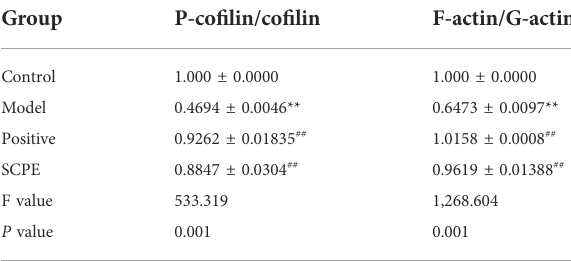
TABLE 6 Effect of SCPE on CYP19 mRNA expression in the hippocampus of D-galactose model mice (mean ± SD, n = 3).